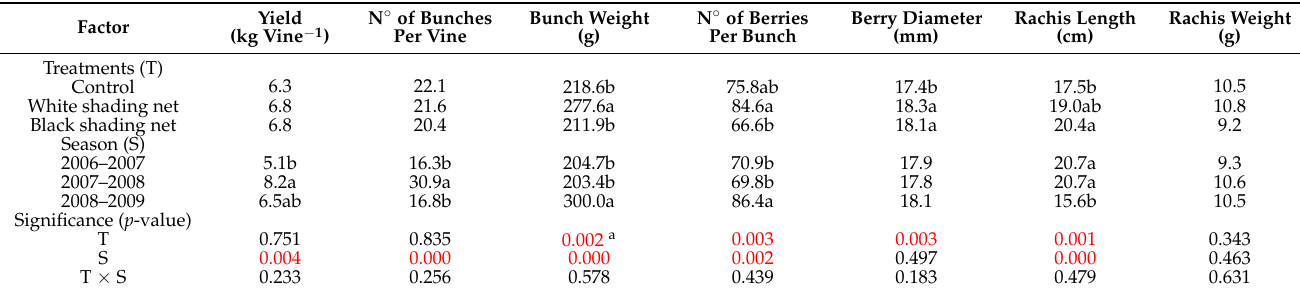
Table 2. Analysis of variance for yield, yield components and bunch characteristics by shading net treatments and control in 2006–07, 2007–08 and 2008–09 seasons. Factor